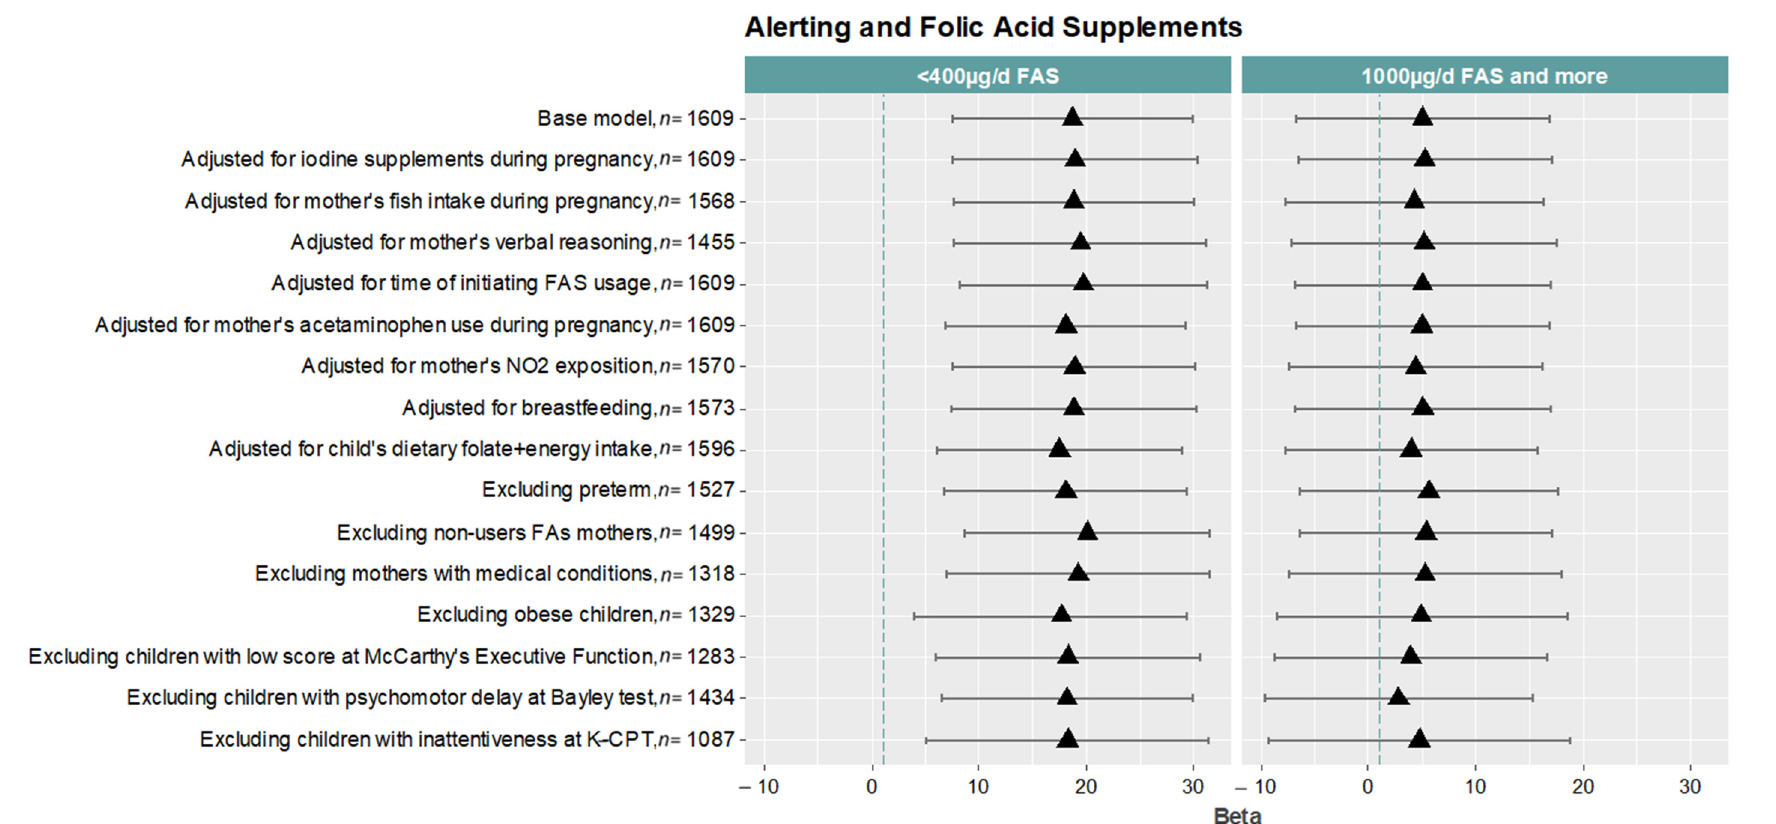
Figure 3. Sensitivity analyses of the associations between FAs use (<400 and ≥ 1000 compared to 400–999 μ g/day) during the second period of pregnancy and alerting in all children ( n = 1609) at age 7–9.